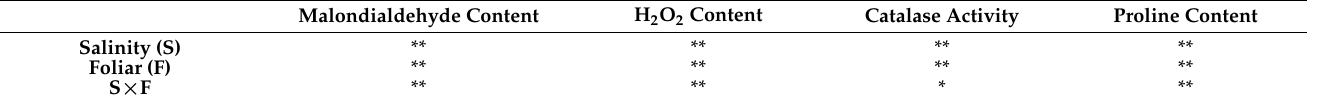
Table 7. ANOVA for the effect of salinity (0–50 and 100 mM NaCl) and foliar applications (no spray, salicylic acid, CeO 2 -nanoparticles, and CeO 2 :SA-nanoparticles) on the MDA, proline, and H 2 O 2 content and CAT activity in Portulaca oleracea